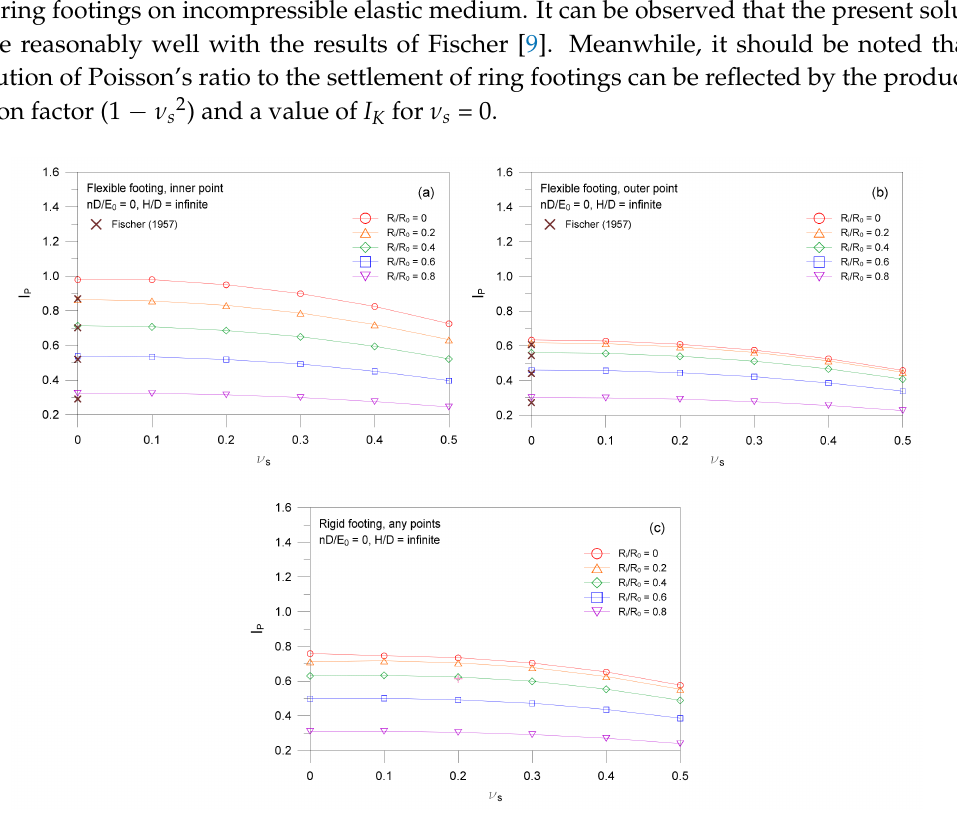
Figure 4. Variation of I P with ν s for ring footings on homogeneous infinite soil: ( a ) flexible footing of inner point; ( b ) flexible footing of outer point; ( c ) rigid